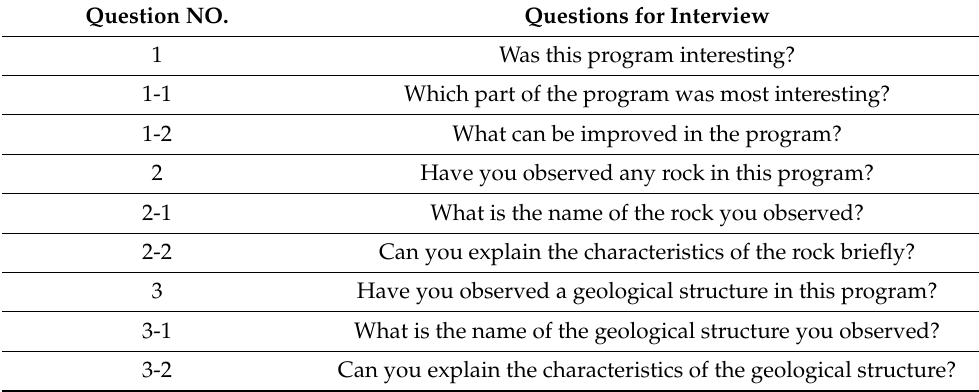
Table 4. Question Configuration for Individual Interviews.